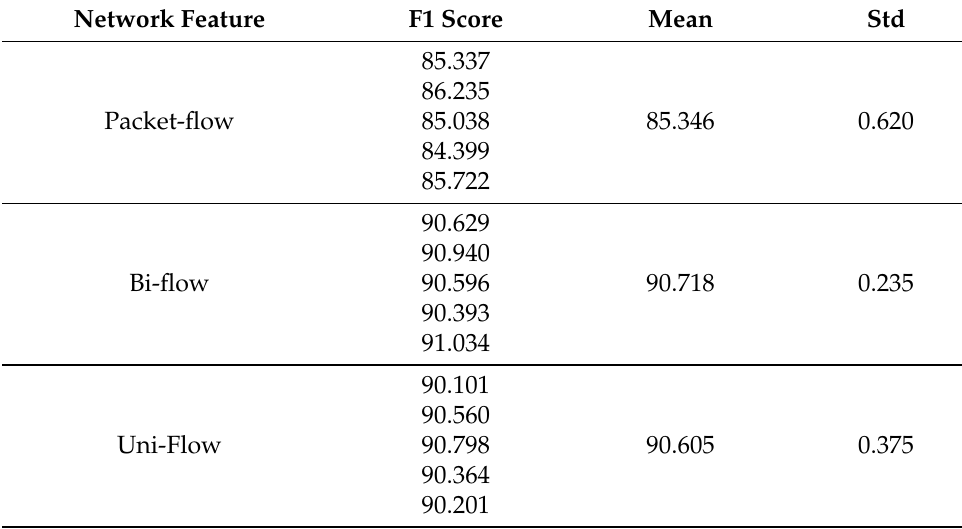
Table 16. Multi-class attacks classification results in term of